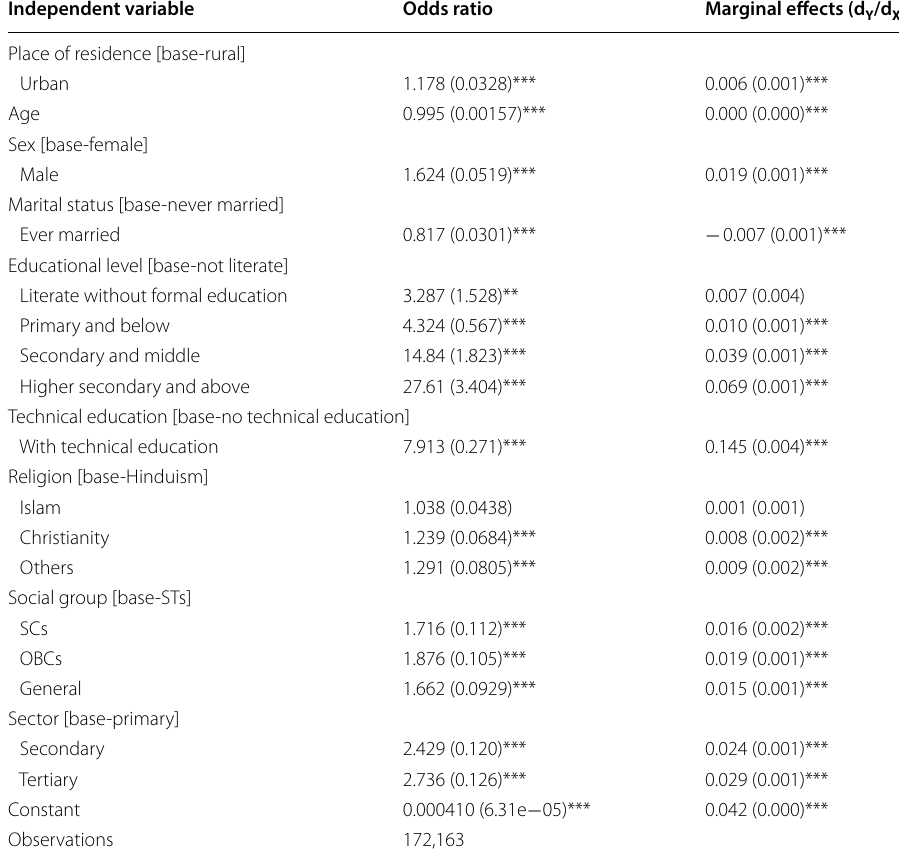
Standard errors in parentheses For column (2), d Y /d X for factor levels is the discrete change from the base